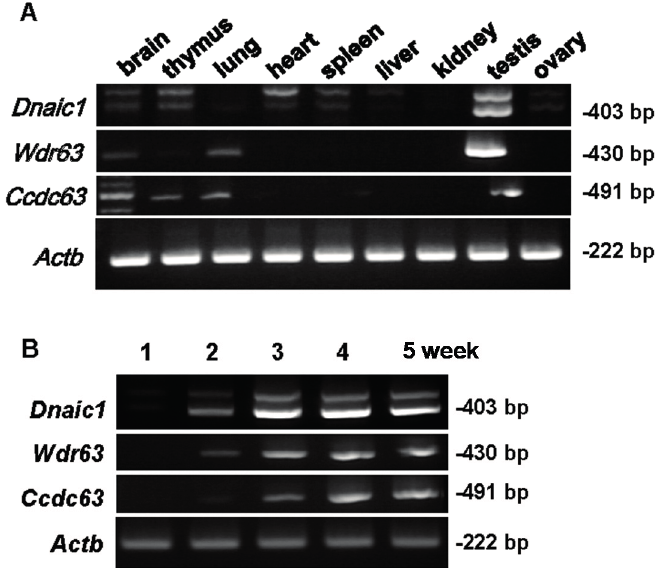
Figure 1. RT-PCR for Dnaic1 , Wdr63 , and Ccdc63 primer sets. ( A ) cDNA library for various tissues; ( B ) cDNA from mouse testes at 1–5 weeks postnatal; Actb ( β -actin ) as control. Size of band shown on the